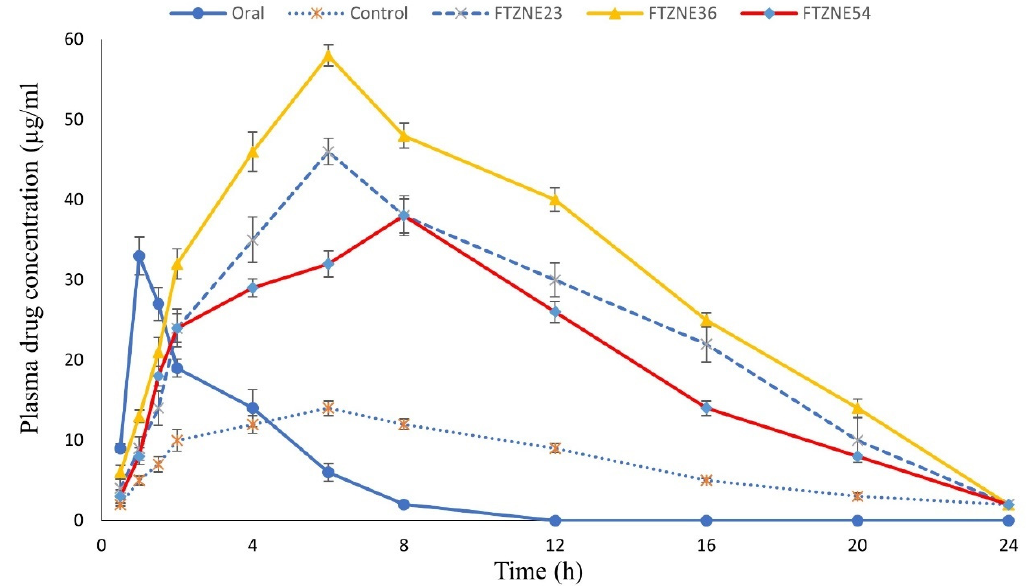
Figure 4. Pharmacokinetic profiles of transdermal formulations (FTZNE23, FTZNE36, and FTZNE54) compared with oral and control formulations in rabbits, n = 3, mean ± S.D.